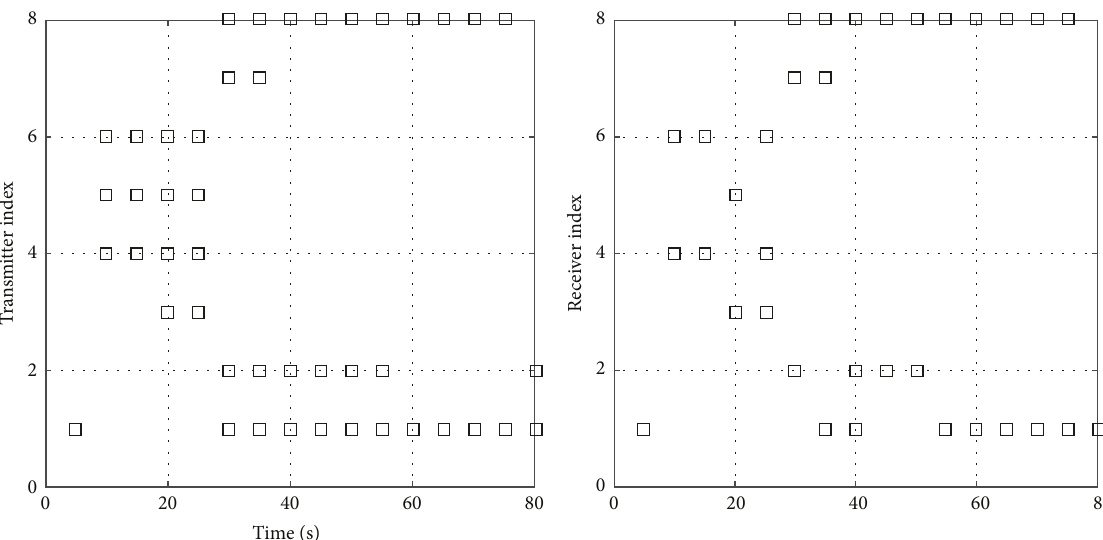
Figure 7: Optimal antenna selection results by MFMLS_OAT